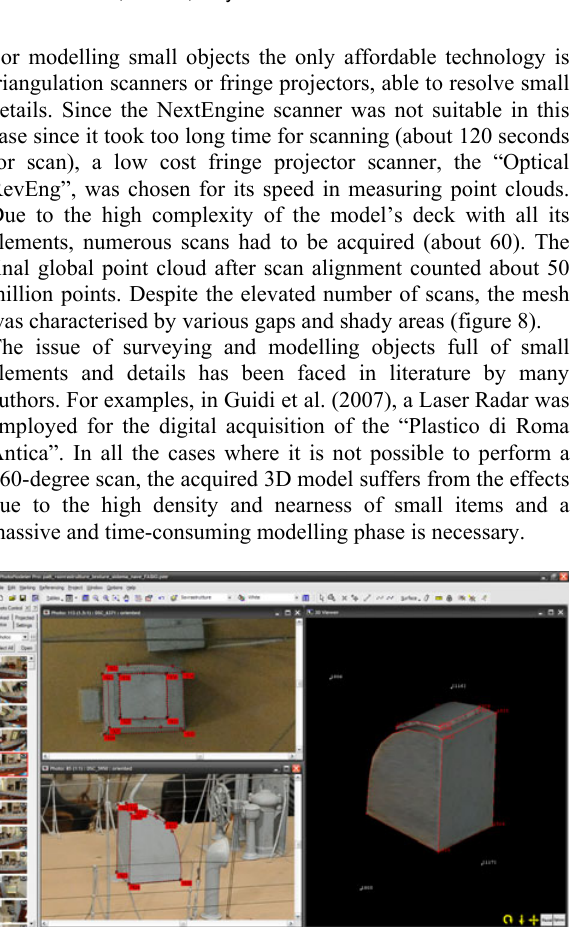
Figure 9: Photogrammetric modelling of simple geometric features.